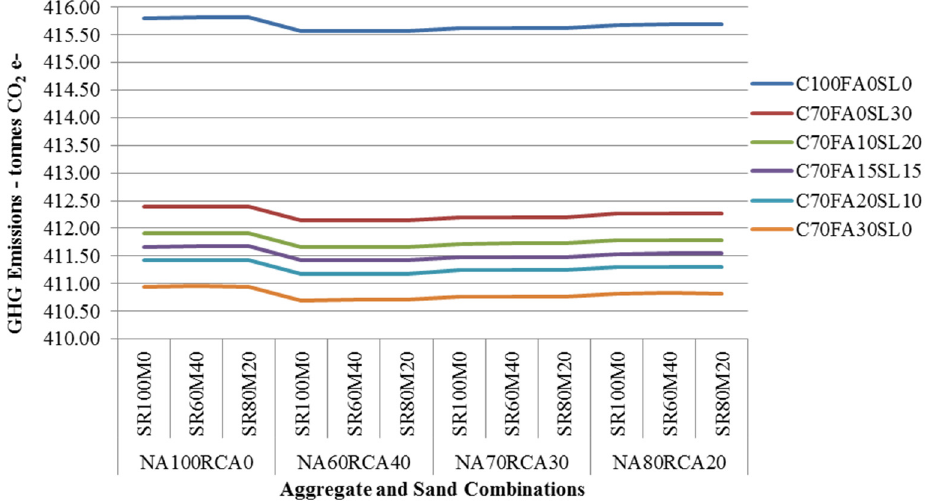
Figure 5. GHG Emissions of CCSWH using by ‐ products for concrete.